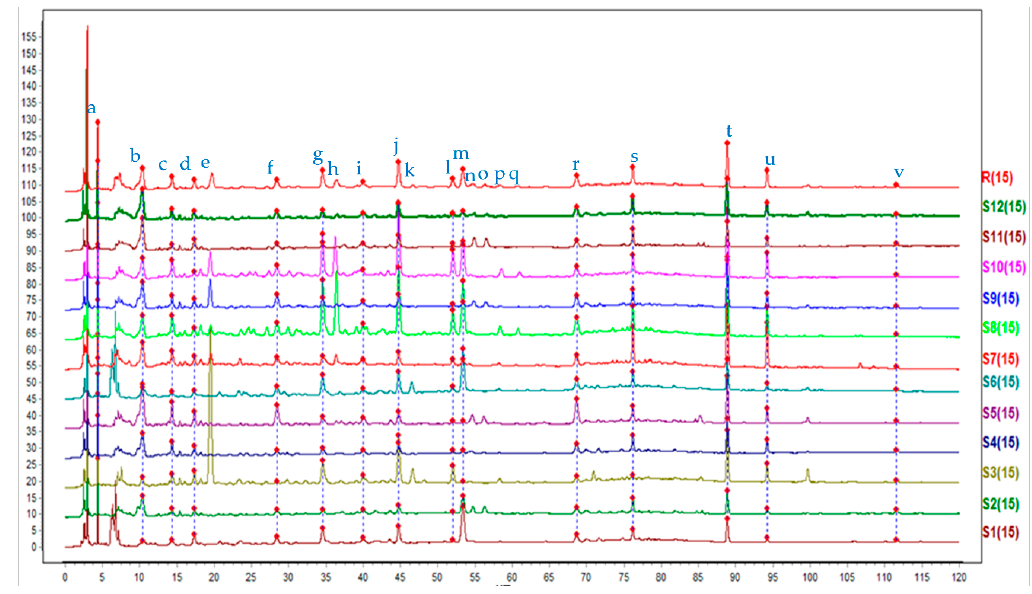
Figure 1. Covered HPLC chromatograms of samples from No. S1 to S12. The common pattern (marked R) was obtained by SES.